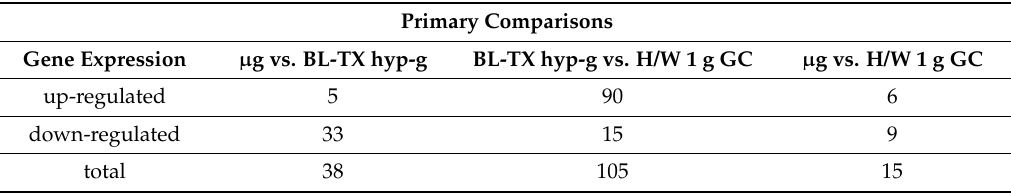
U937 cells during a suborbital rocket flight. Direct comparisons between the samples groups are shown.